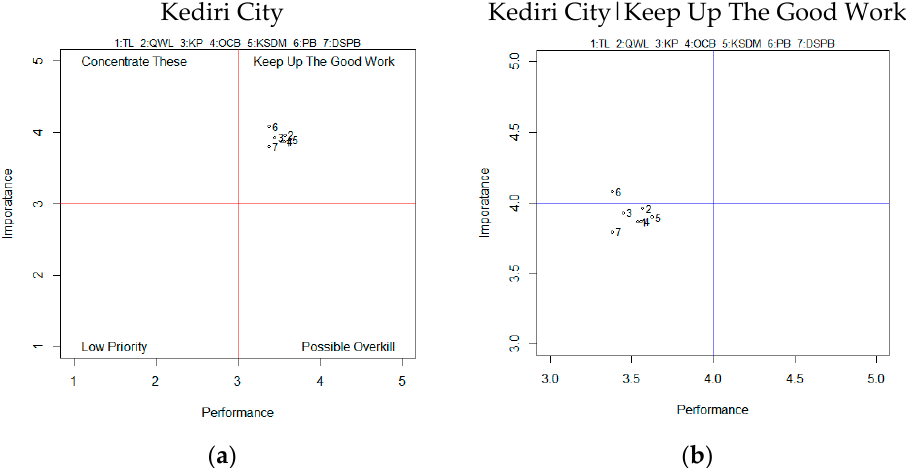
Figure 8. ( a ) IPA Cartesian Diagram of Kediri City. ( b ) IPA Cartesian Diagram of Keep up the Good Work Quadrant of Kediri City.